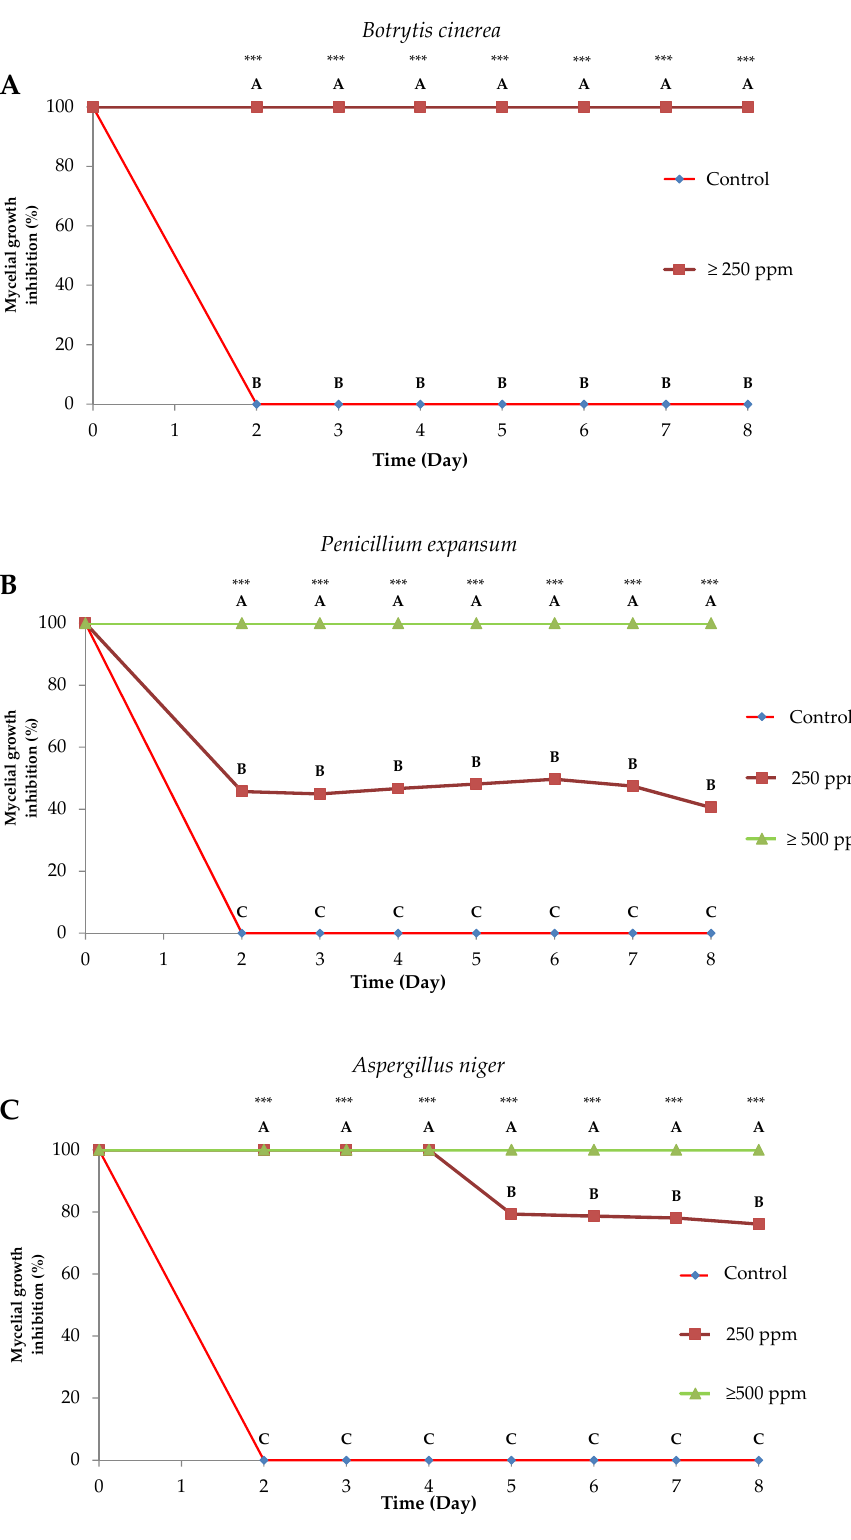
Figure 3. Evolution of mycelial growth inhibition (%) (mean ± standard error) of Botrytis cinerea ( A ), Penicillium expansum ( B ), and Aspergillus niger ( C ) by different concentrations of T. kotschyanus EO (ppm). A – C mean values not followed by a common letter differ significantly (*** significant at p < 0.001).